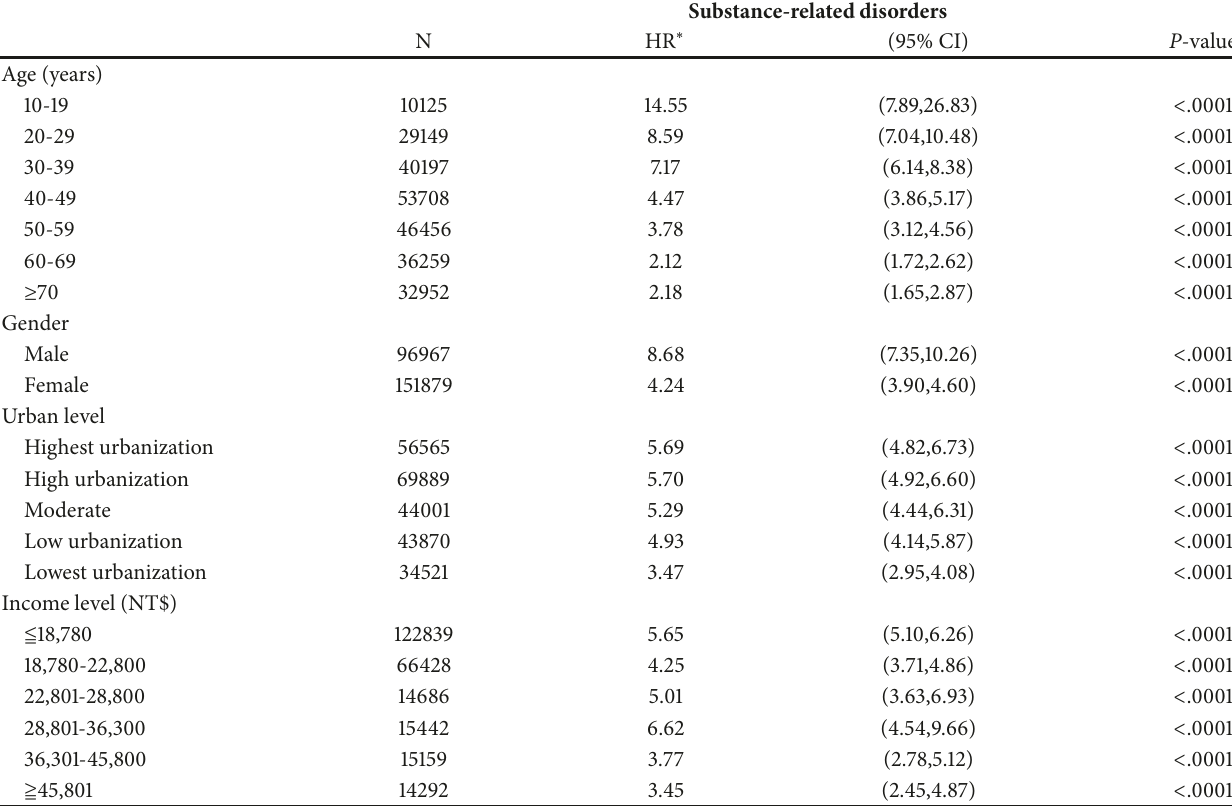
Table 4: Estimated hazard ratio of the subsequent onset of substance-related disorders (mental illness vs. control) for